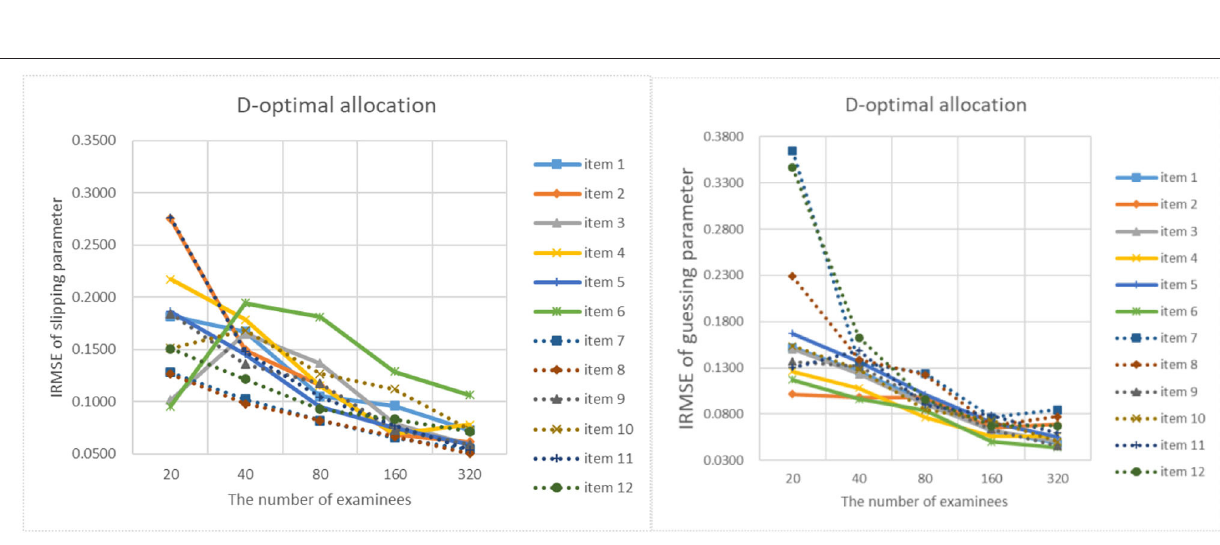
and the last one fifth are used to estimate item